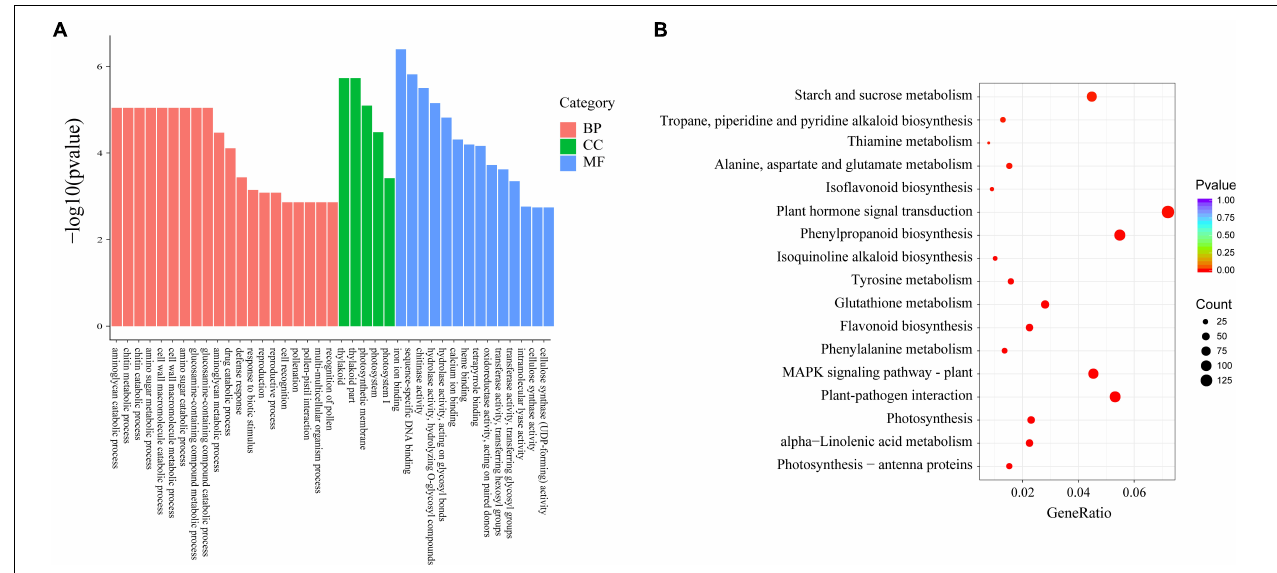
FIGURE 3 | Functional analysis of 1,688 DEGs. (A) GO enrichment of DEGs. (B) KEGG enrichment of DEGs.